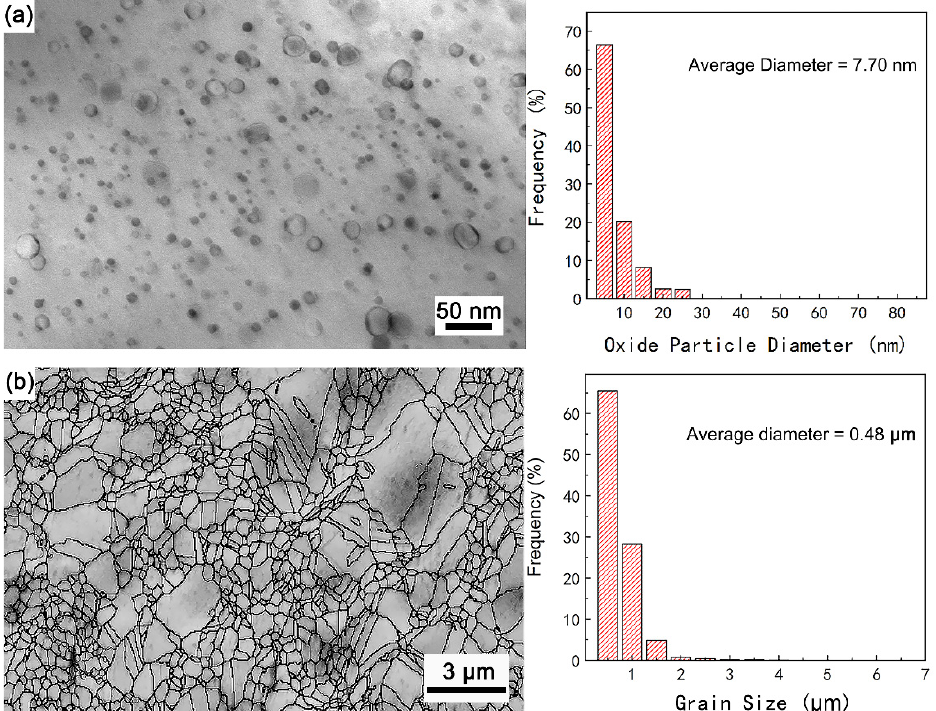
Figure 1. ( a ) TEM image and size distribution of secondary phase oxides and ( b ) EBSD image and size distribution of grains in the as ‐ HIP ‐ treated S1.